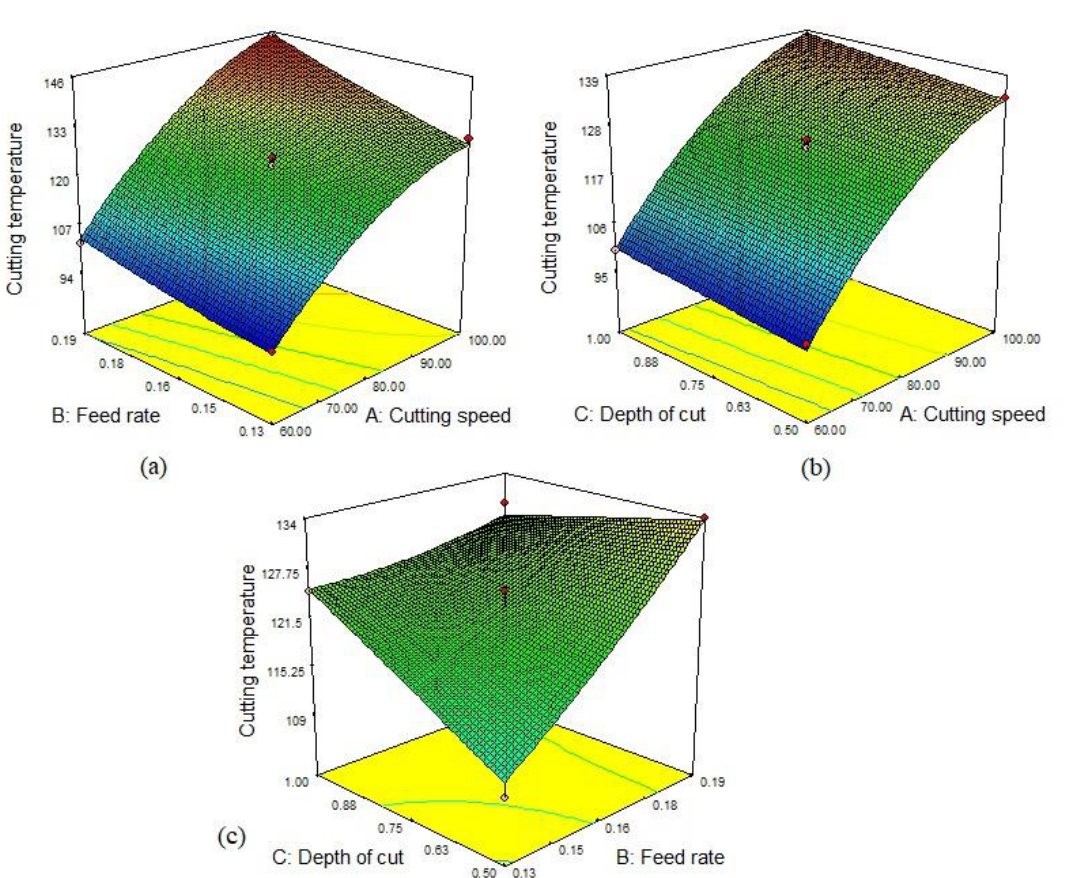
Figure 8. (a-c) esteemed response surface plot for cutting